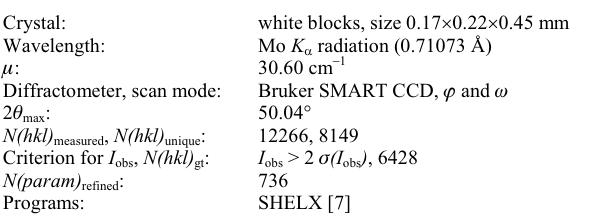
Table 1. Data collection and handling.